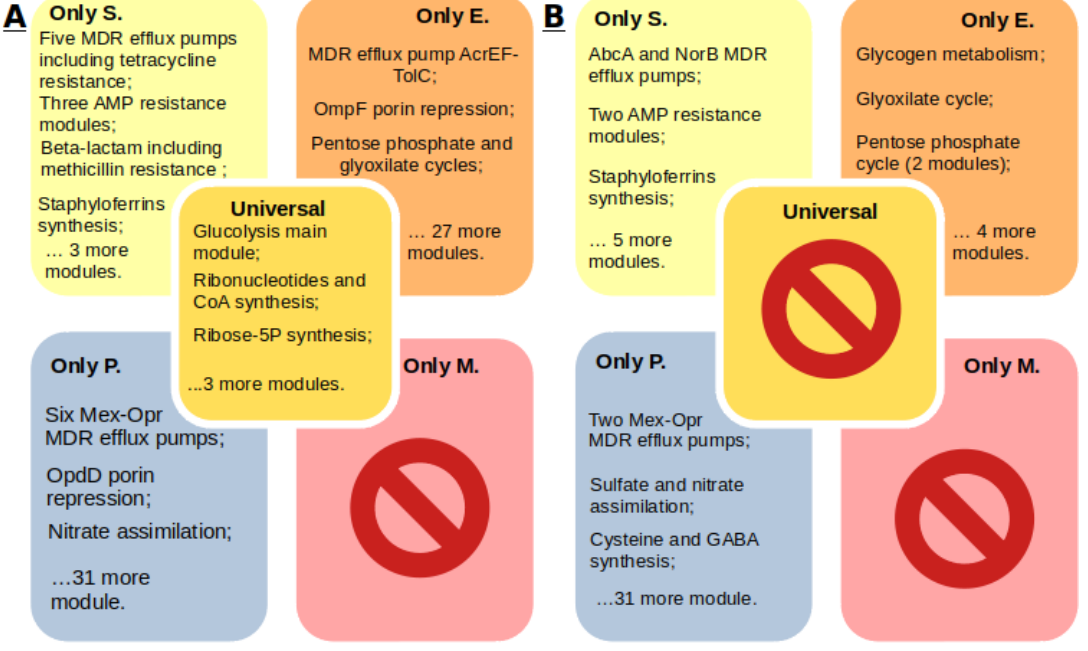
Figure 8. Unique and universal features found in the analysis of pangenomes ( A ) and core genomes ( B ) of S. aureus (S) , Enterobacter spp. (E), P. aeruginos a (P), and Mycoplasma spp. (M). MDR denotes multidrug resistance.